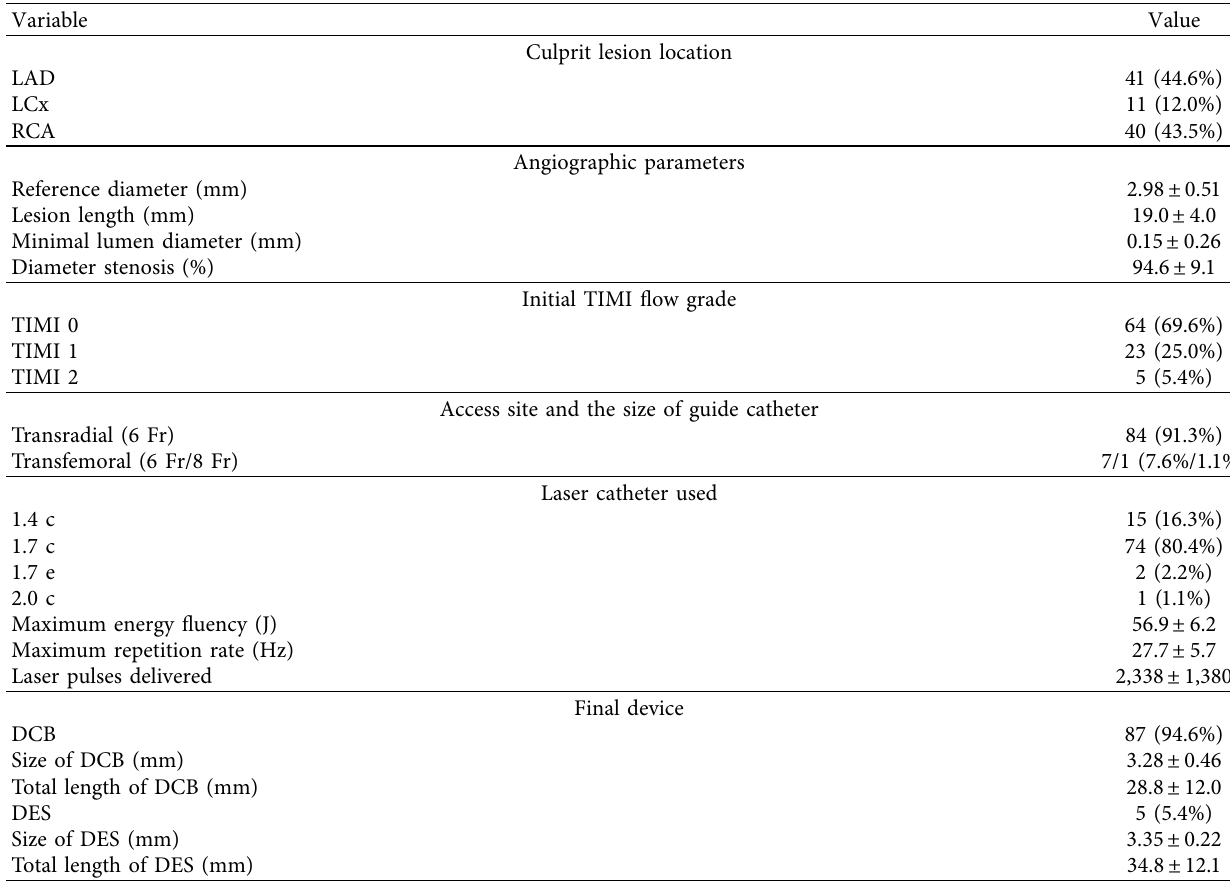
Table 2: Lesion and procedural characteristics.